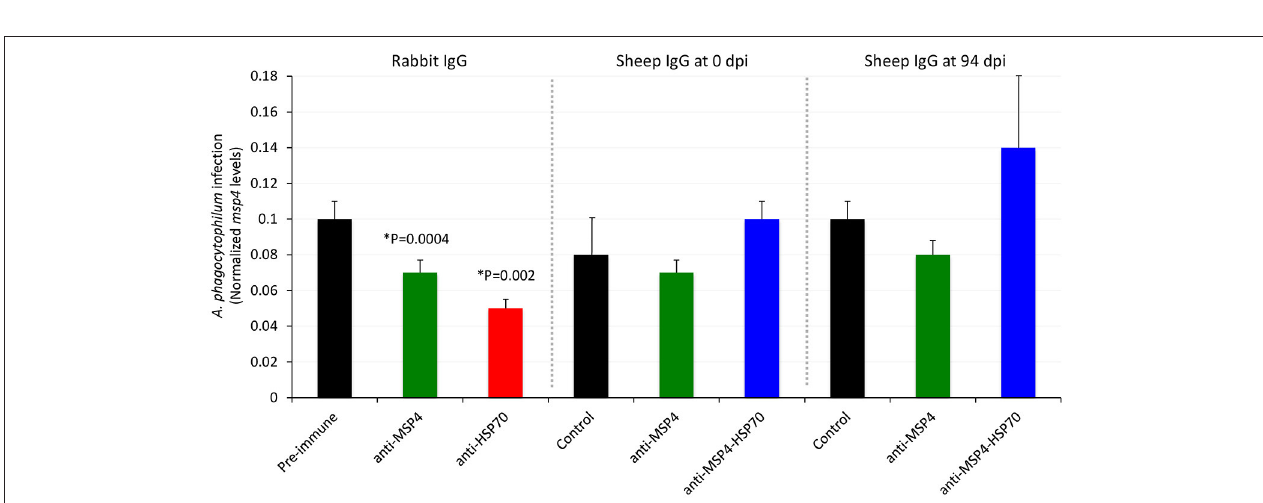
FIGURE 6 | Role of antibodies against recombinant proteins from immunized lambs in the inhibition of A. phagocytophilum infection of HL60 human cells. Sheep IgG antibodies against A. phagocytophilum MSP4 and MSP4-HSP70 recombinant proteins were obtained from control and immunized sheep at 0 and 94 dpi and used to characterize the inhibition of pathogen infection of HL60 human cells. Treatments included purified IgGs from rabbit pre-immune, anti-MSP4 and anti-HSP70 sera. Purified IgGs were mixed with A. phagocytophilum inoculum of human NY18 isolate for 60 min before being placed on the cell monolayers. A. phagocytophilum infection levels were determined by msp4 real-time PCR normalizing against human β -actin . Results were compared between groups treated with pre-immune/control and anti-MSP4/HSP70 antibodies by the Student’s t -test with unequal variance (* P < 0.05; N = 4 replicates per treatment).